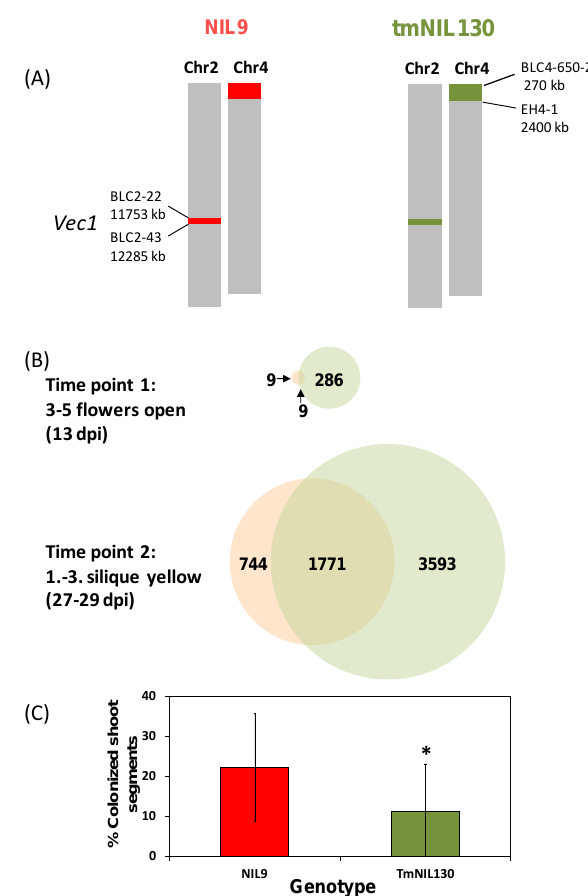
Figure 6. Differential gene expression and systemic colonization after V. longisporum infection in two (Bur × L er )-NILs differing in a region within the colonization resistance QTL vec1 . ( A ) Genotype of NIL9 and tmNIL130 in the variable regions. Red parts stand for L er alleles, green parts for Bur alleles in the variable regions. Grey parts are isogenic with respect to the tested marker loci (for marker grid in isogenic regions see [79]). Names and physical positions in kilobases (kb) of markers delimiting variable regions are given next to the bars representing chromosomes. For primer information see Supplementary File Table S1; ( B ) Genes differentially expressed by V. longisporum infection in the